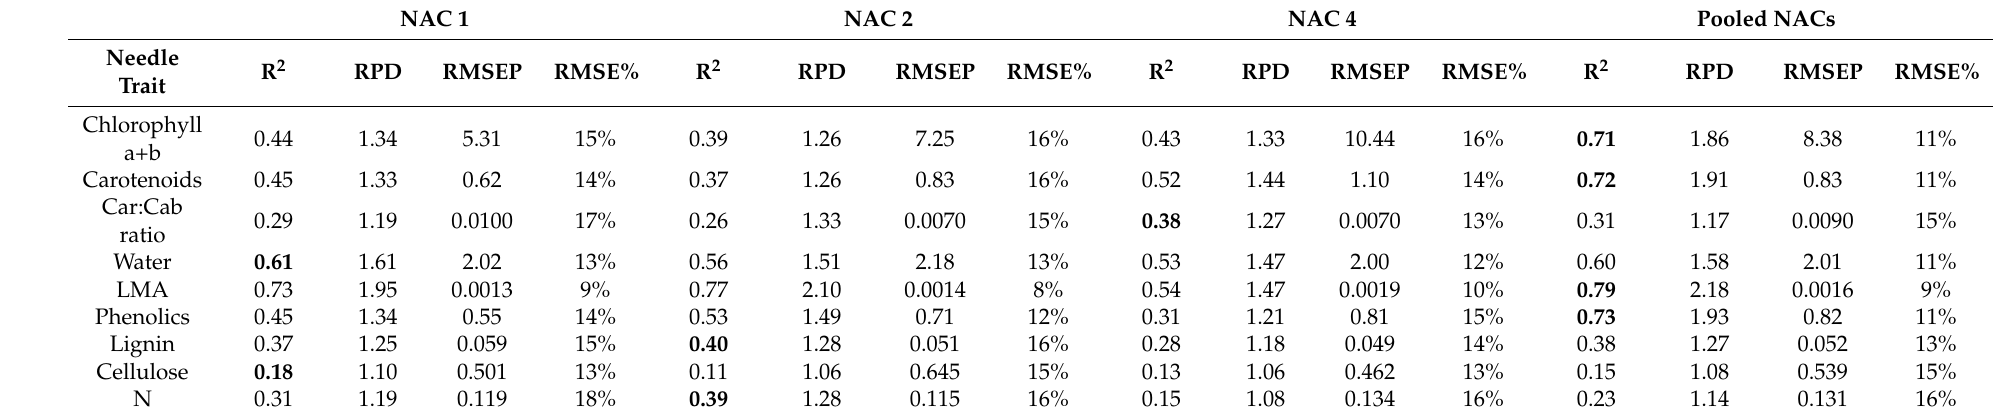
Table 2. Parameters of partial least square regression (PLSR) models’ cross-validation of selected needle traits from needle spectra (450–2000 nm). Parameters for separated models for NAC1, NAC2 and NAC4 are presented, then parameters for the model of all NACs pooled are shown. R 2 —coefficient of determination; RPD—the ratio of performance to deviation; RMSE—root mean square error of validation dataset (in absolute values of given trait); RMSE%—RMSE expressed as a percentage of the training dataset range. The best performing model according to the highest R 2 is highlighted in